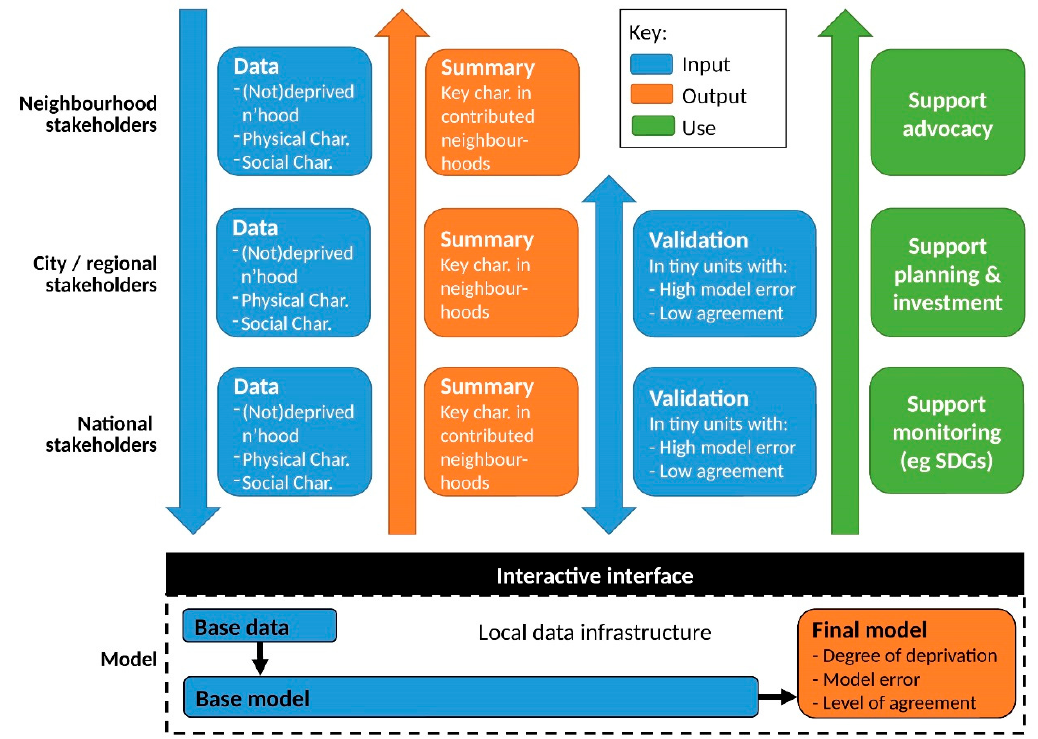
Figure 4. Framework for an Integrated Deprived Area Mapping System (IDEAMAPS).